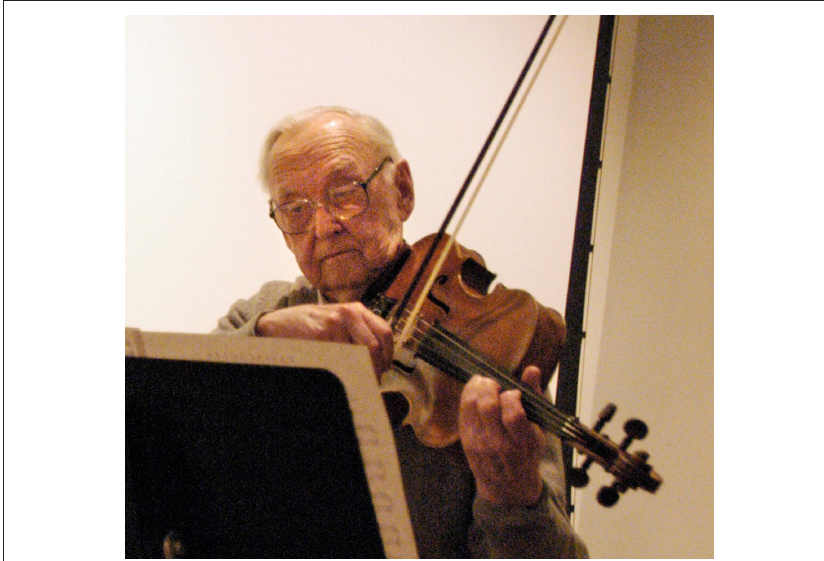
Figure 1 | Professor Crow, playing his viola on his 90th birthday (Photo courtesy of Jeff Miller, university of